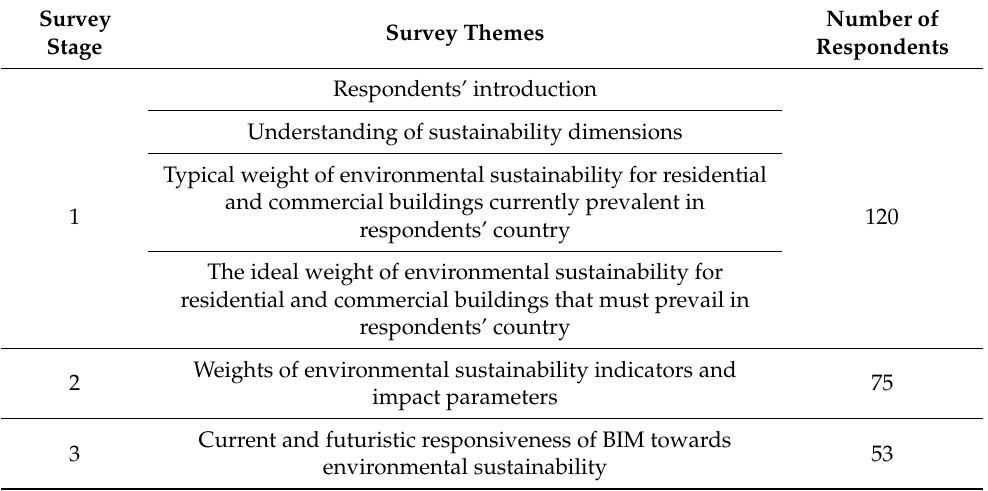
Table 2. Questions in different stages of the